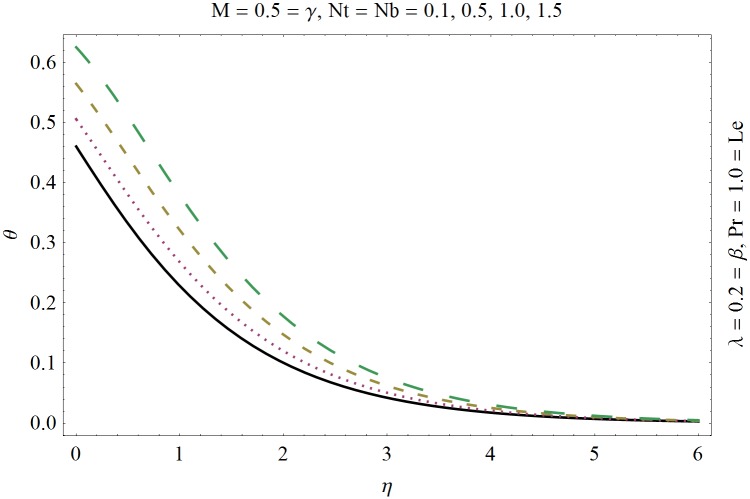
Influence of (N
b, N
t) on θ.